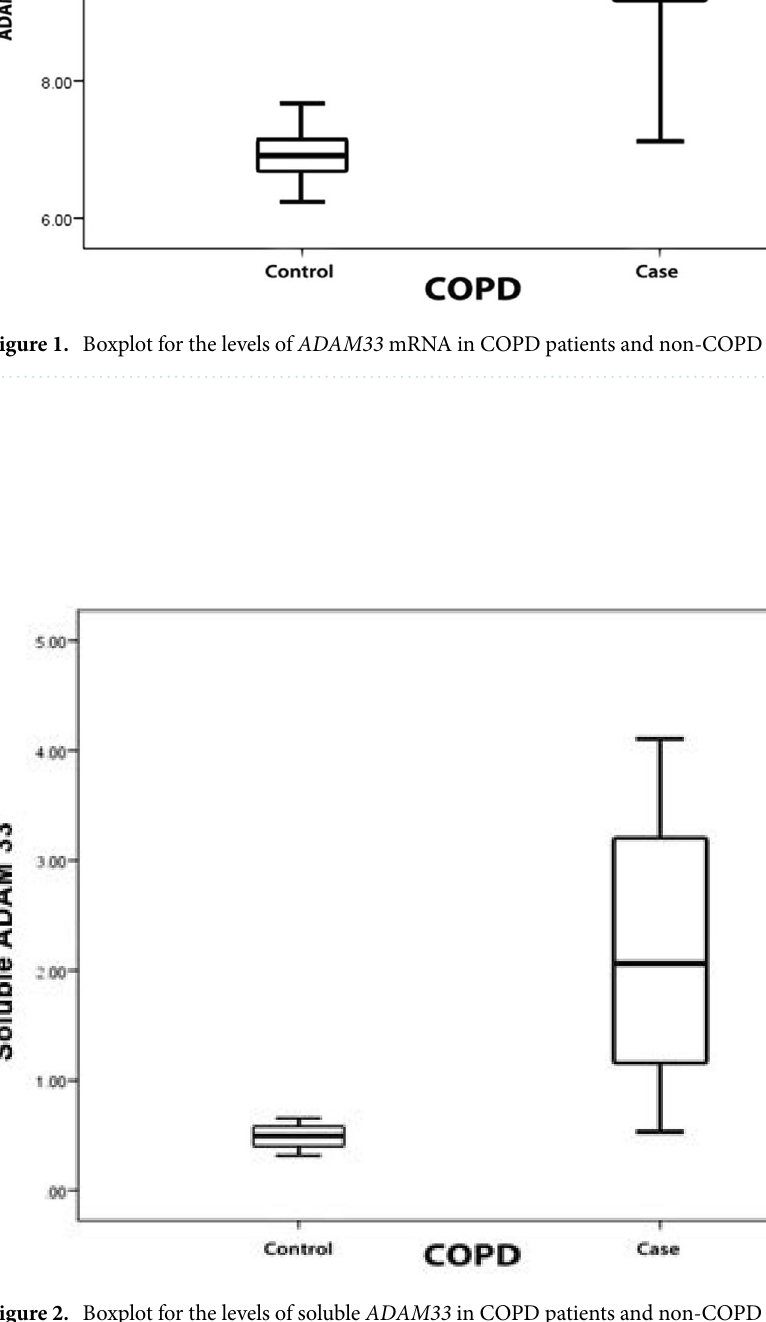
Figure 2. Boxplot for the levels of soluble ADAM33 in COPD patients and non-COPD